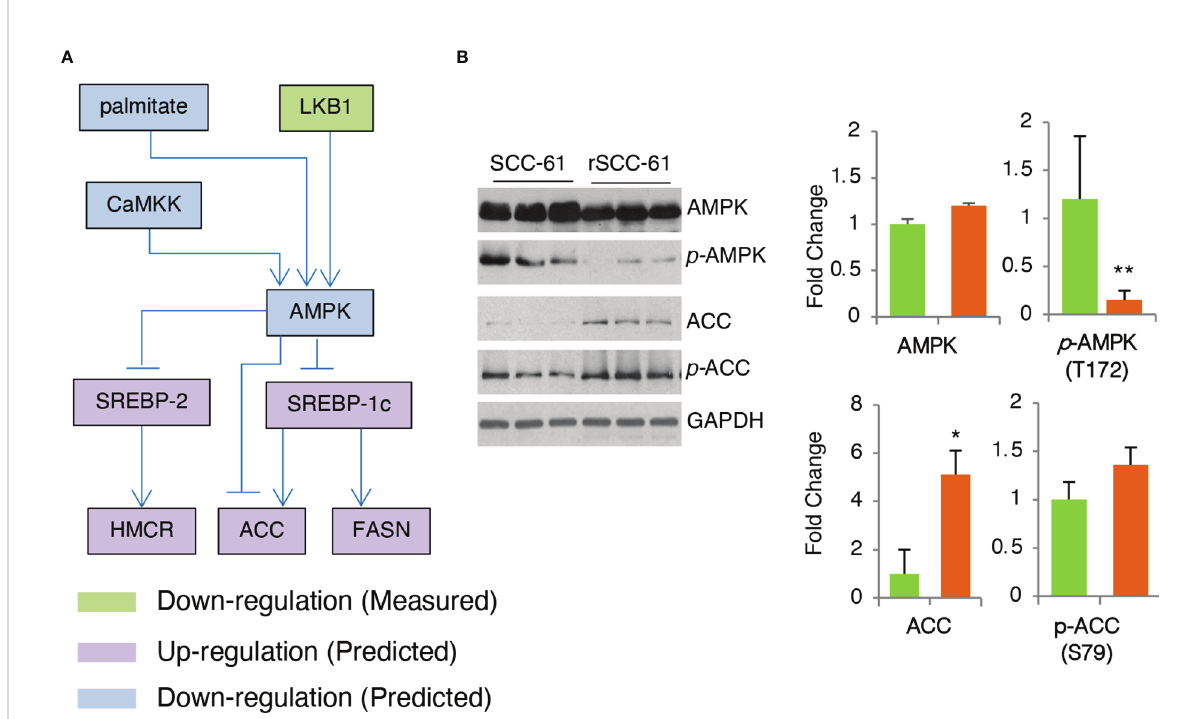
FIGURE 5 Validation of COSM ro Subnetwork Connecting AMPK Activity to Fatty Acids and Cholesterol Metabolism. (A) Inferred network predicting down- regulated AMPK and upregulated ACC, FASN in rSCC-61 cells. (B) Western blot analysis of SCC-61 and rSCC-61 cell lysates for AMPK, pAMPK (T172), ACC and pACC (S79), and GAPDH used as a loading control. Quanti fi cation is shown on the right panels ( p values *0.05-0.01, **0.01- 0.001,